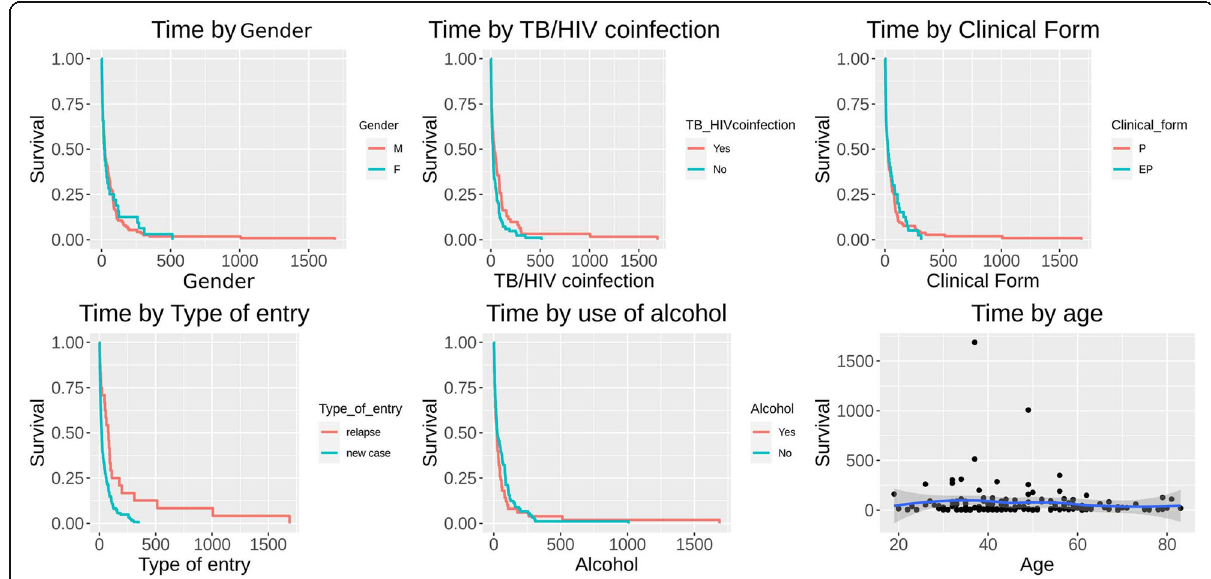
Fig. 2 Curves obtained from the Kaplan-Meier survival analysis of the explanatory variables in patients who died of TB, Curitiba-Brazil. Legend : dispersion time according to age and